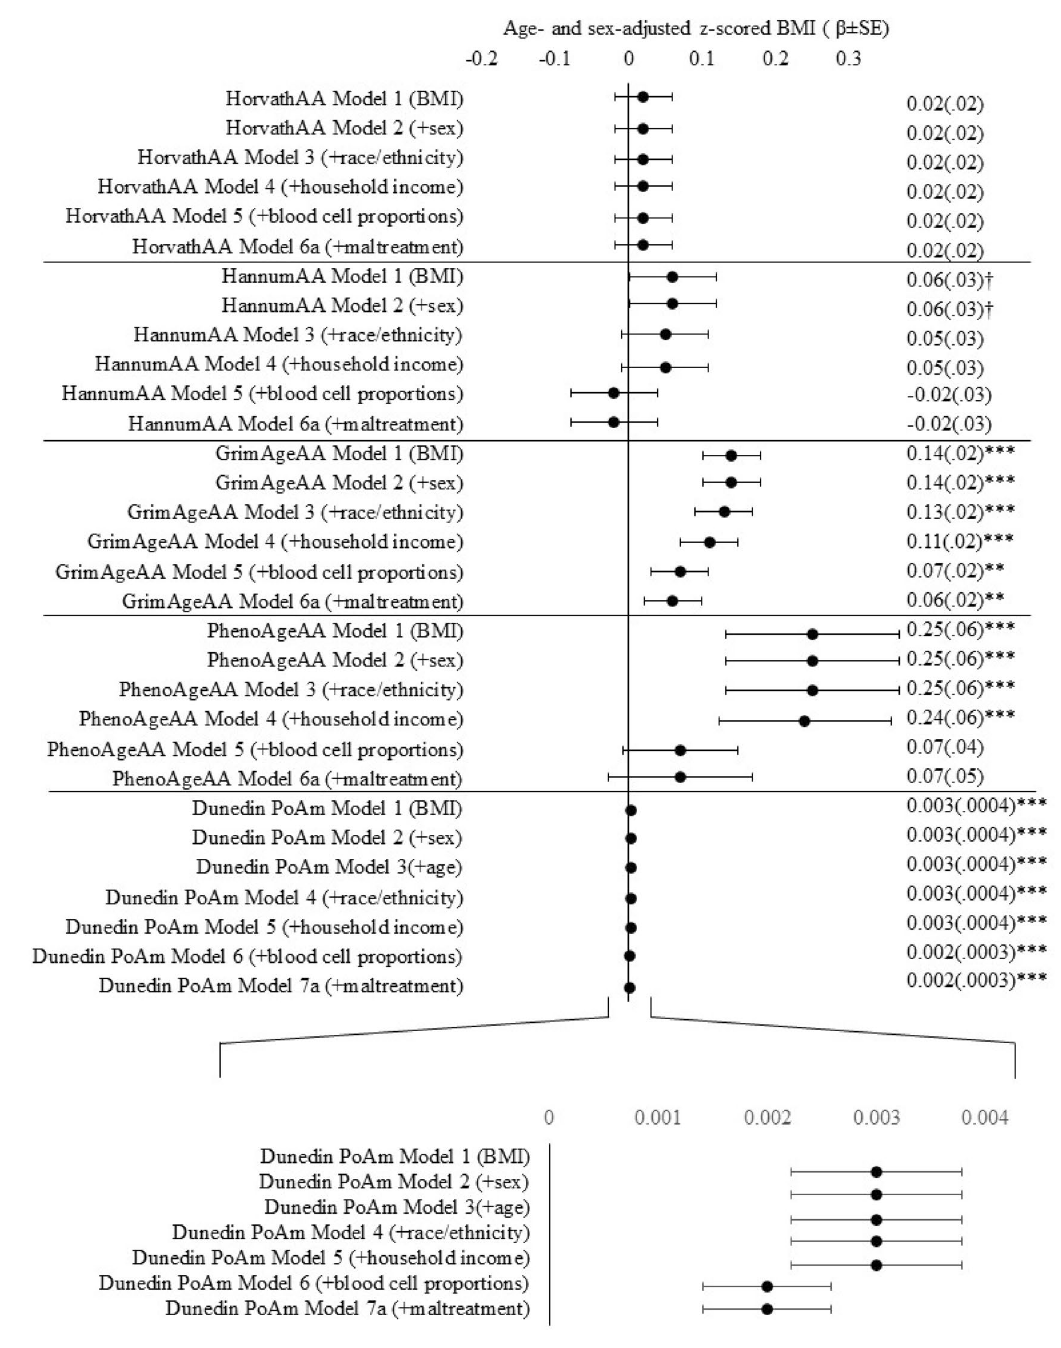
Figure 1. Estimates for BMI z-scores across all accelerated epigenetic aging and DunedinPoAm outcomes. Each row specifies the stepwise addition of a covariate to the base model of accelerated epigenetic aging outcome regressed onto age- and sex-adjusted BMI z-scores. Zoomed-in view of estimates for models for DunedinPoAm. † P < .10, * P < .05, ** P < .01, *** P <